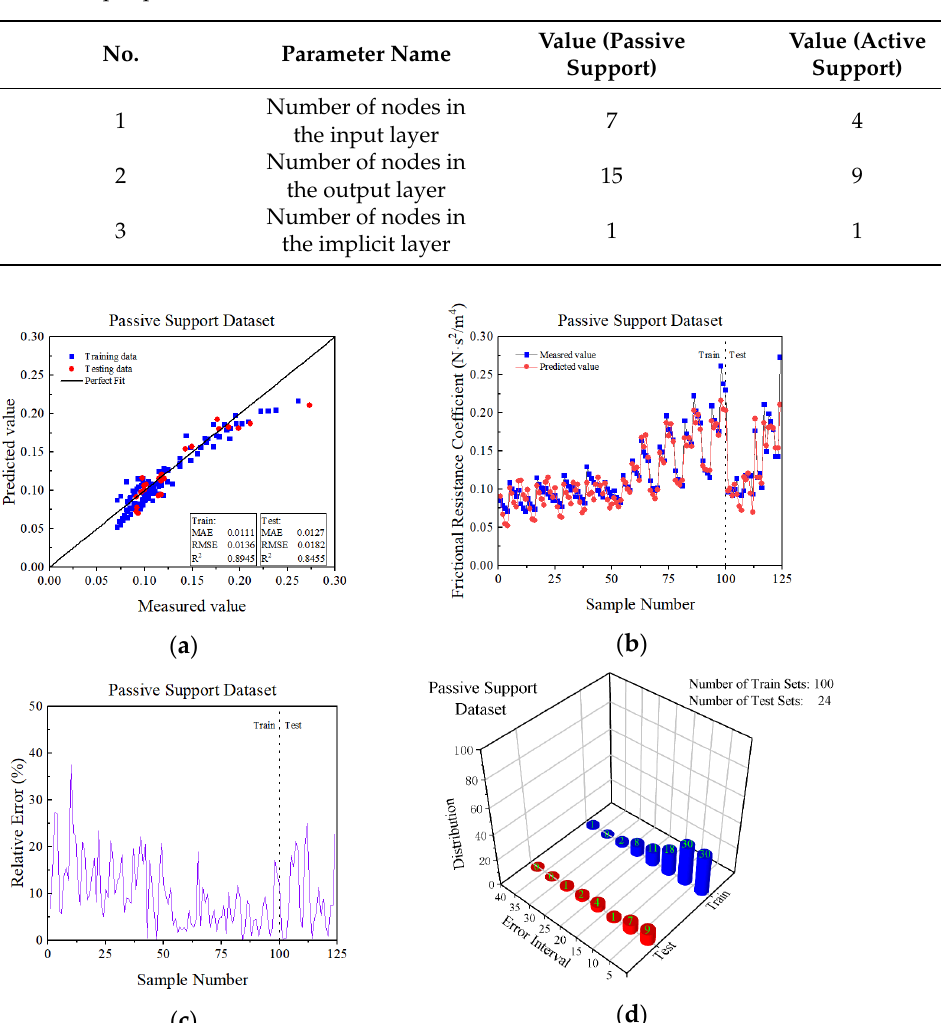
Table 7. Input parameters of the BP model.